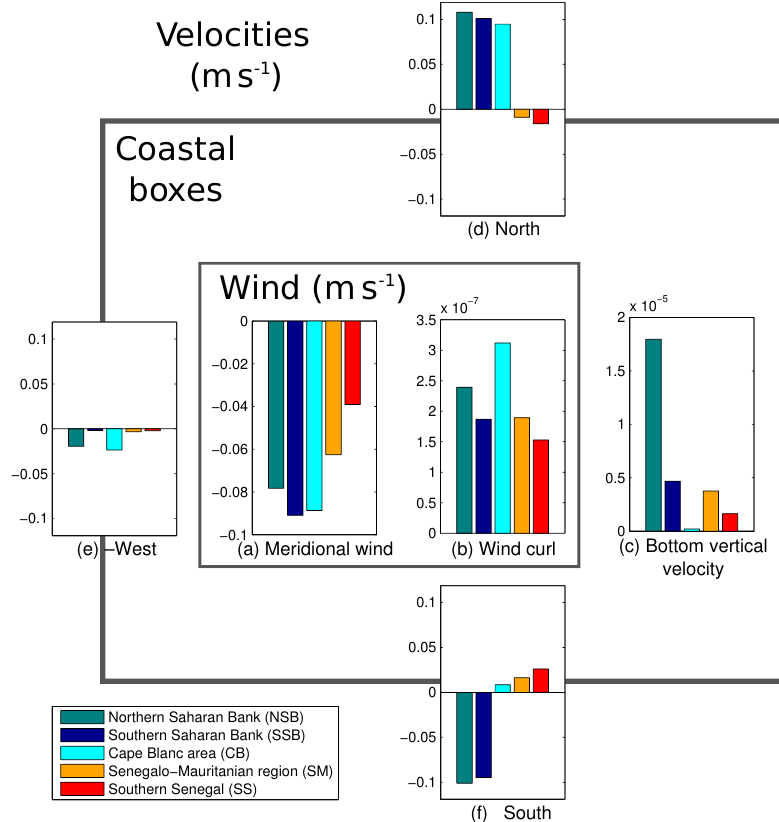
Figure 2. Annual mean of (a) wind intensity (ms − 1 ) and (b) wind curl (s − 1 ) at the surface of the coastal boxes, (c) upwelling intensity (bottom vertical velocity, in ms − 1 ) within the coastal boxes and lateral velocities at the (d) northern, (e) western and (f) southern boundaries (ms − 1 ). Vertical and lateral velocities are defined as positive inward and upward. Each colour corresponds to a box (see